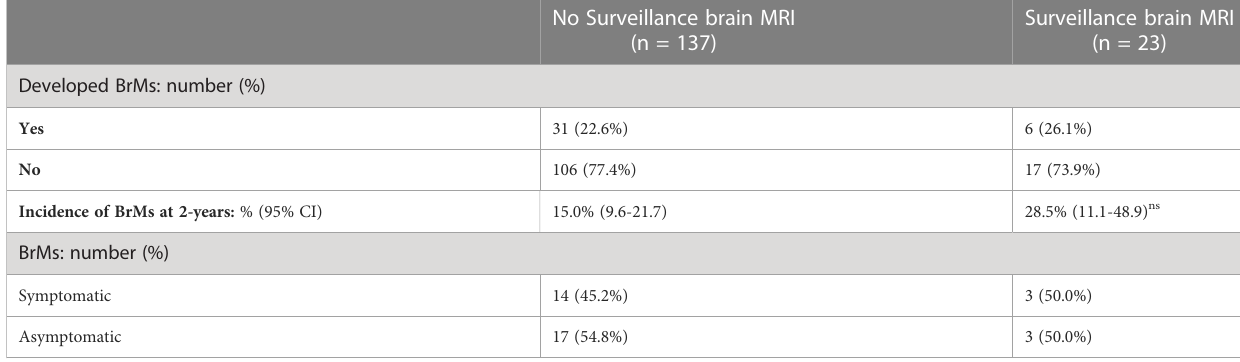
TABLE 2 Comparisons of stage III NSCLC patients who received surveillance brain MRI and those who did not.